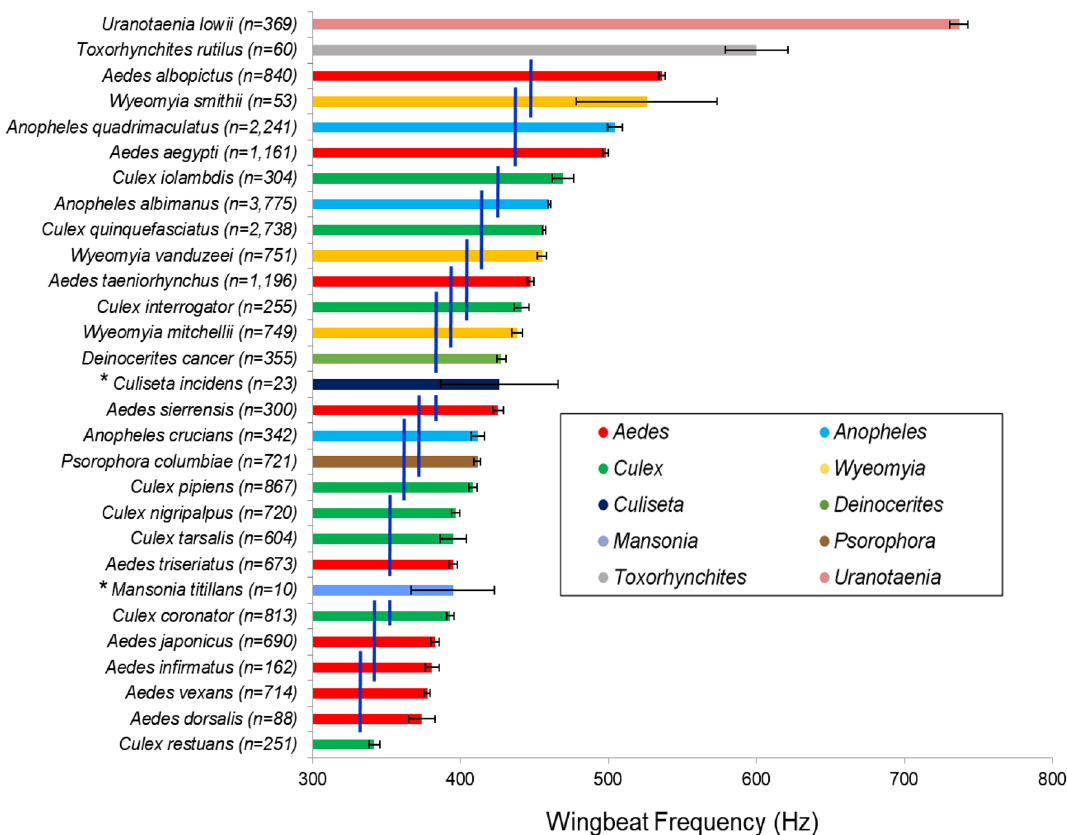
Figure 1. Wingbeat frequencies for 29 mosquito species. Bars (mean wingbeat frequency) are color-coded by the mosquito genus. Error bars represent 95% confidence interval. Overlapping vertical blue lines indicate species means that are not significantly different ( P > 0.05). *Species with fewer than 20 valid data points (wingbeat files) were excluded from the